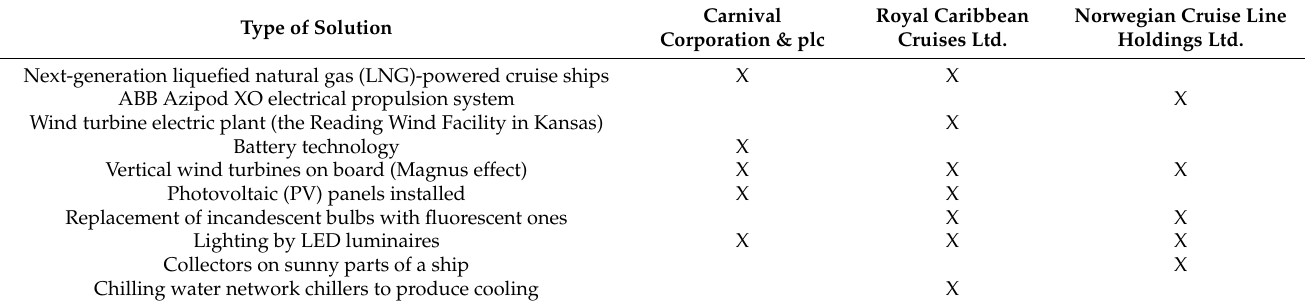
Table 4. Eco-energy solutions on cruise ships in the world’s largest cruise shipping companies [27–30]. Type of